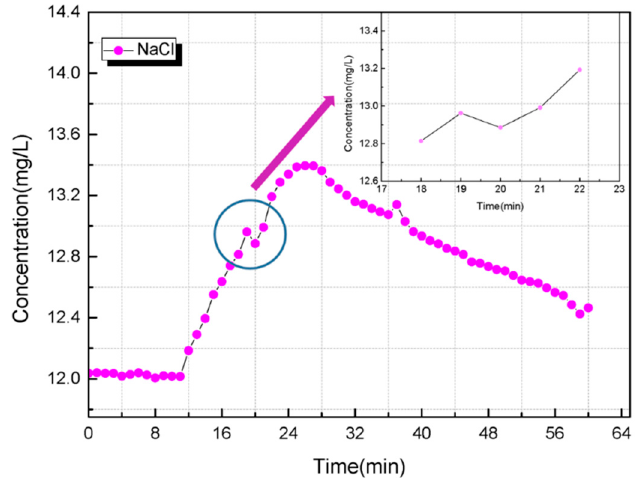
Figure 7. The NaCl concentration–time curve of D2.